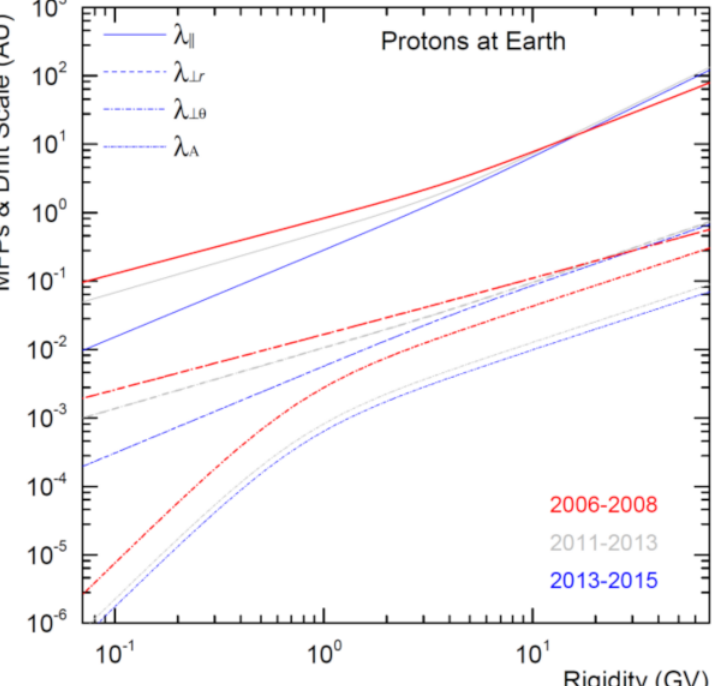
Figure 3. The MFPs, λ (cid:107) , λ ⊥ r , λ ⊥ θ , and the drift scale λ D ( ≡ λ A ) , from top to bottom, are shown for protons (assumed to be the same for anti-protons) as a function of rigidity but now averaged over three distinctive periods for solar minimum conditions from 2006–2008 (red lines), for increasing solar activity from 2011–2013 (grey lines) and for maximum activity conditions from 2013–2015 (blue lines); at Earth λ ⊥ θ = λ ⊥ r